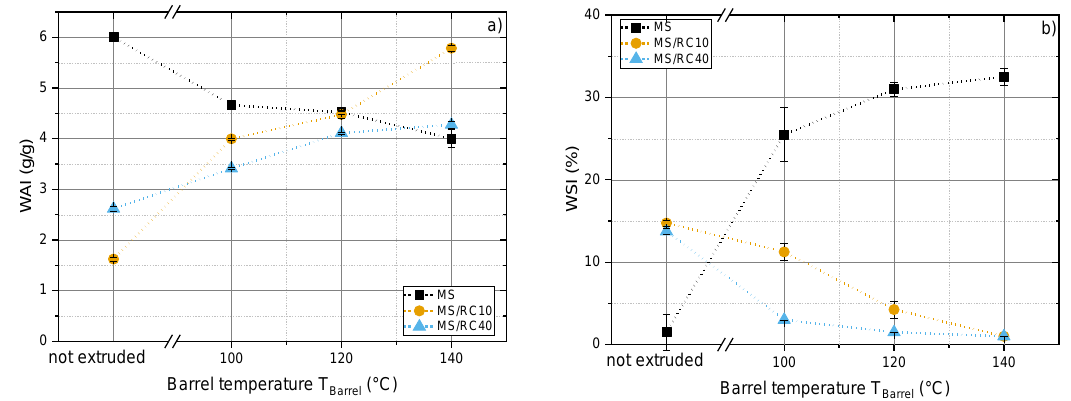
Figure 7. Water absorption and solubility. ( a ) Water absorption index (WAI) and ( b ) water solubility index (WSI) as a function of barrel temperature (T Barrel = 100, 120, 140 °C) of maize starch (MS) blended with 10 or 40 g/100 g (w.b.) rapeseed press cake (RPC) extruded at 29 g/100 g (d.m.) moisture content. Lines have been added for visual clarity.